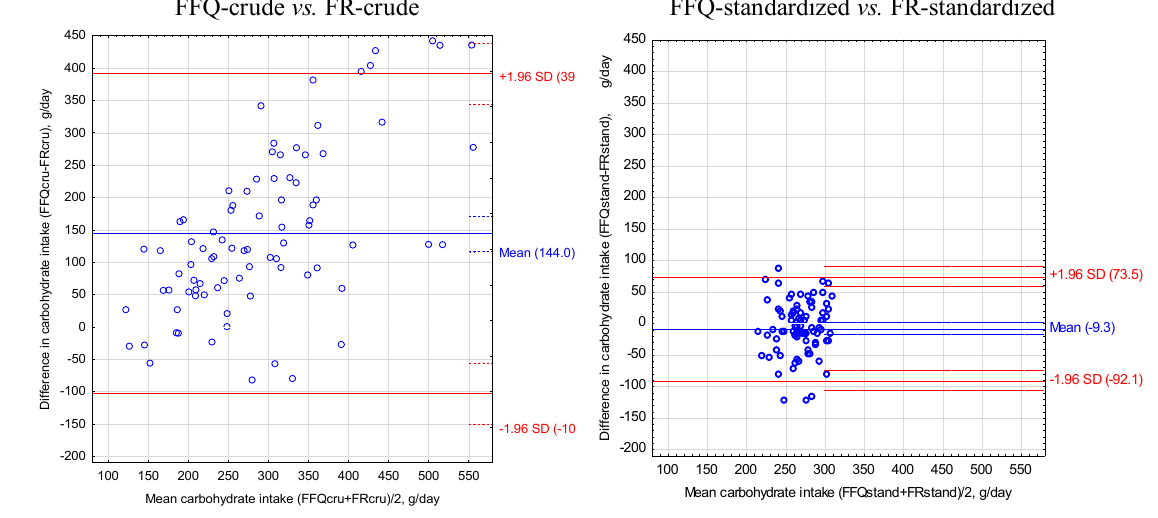
Figure 3. Bland-Altman plots to assess agreement between the food frequency questionnaire (FFQ) and three-day unweighted food record (FR) for carbohydrates intake in 84 women. FFQ-crude vs. FR-crude FFQ-standardized vs.